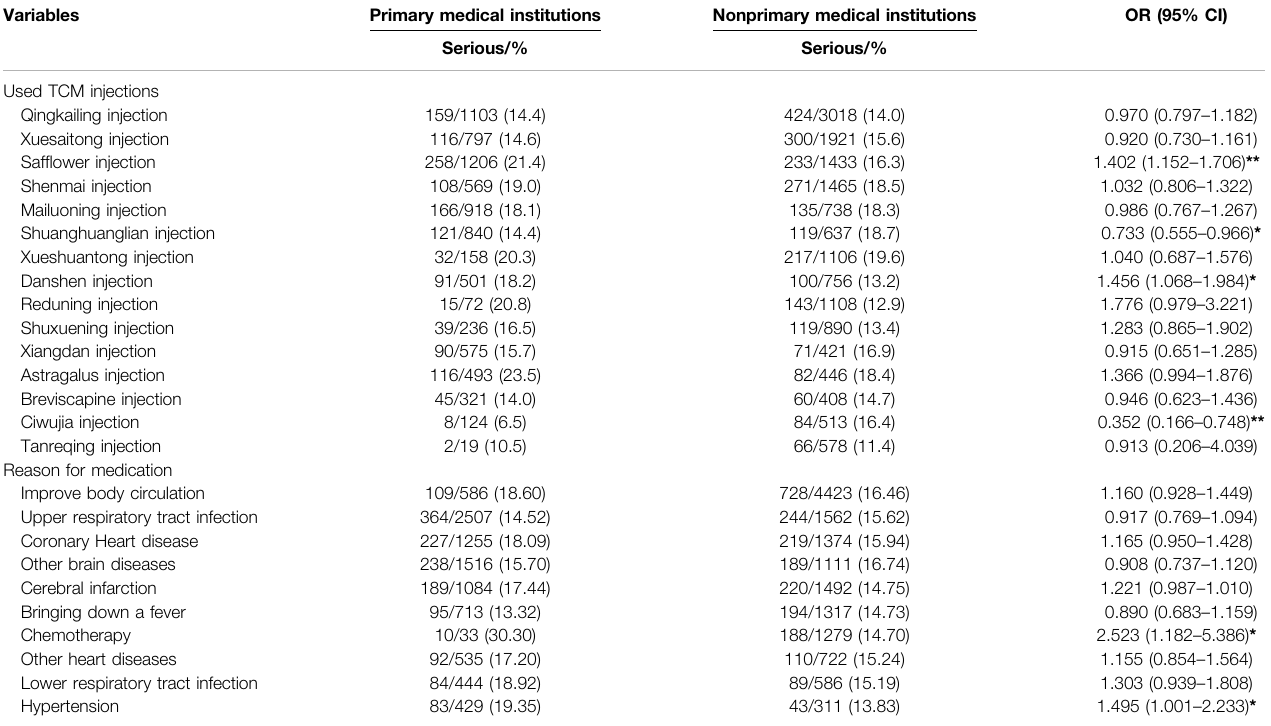
TABLE 7 | Hierarchical analysis of the Types of drugs and reasons for